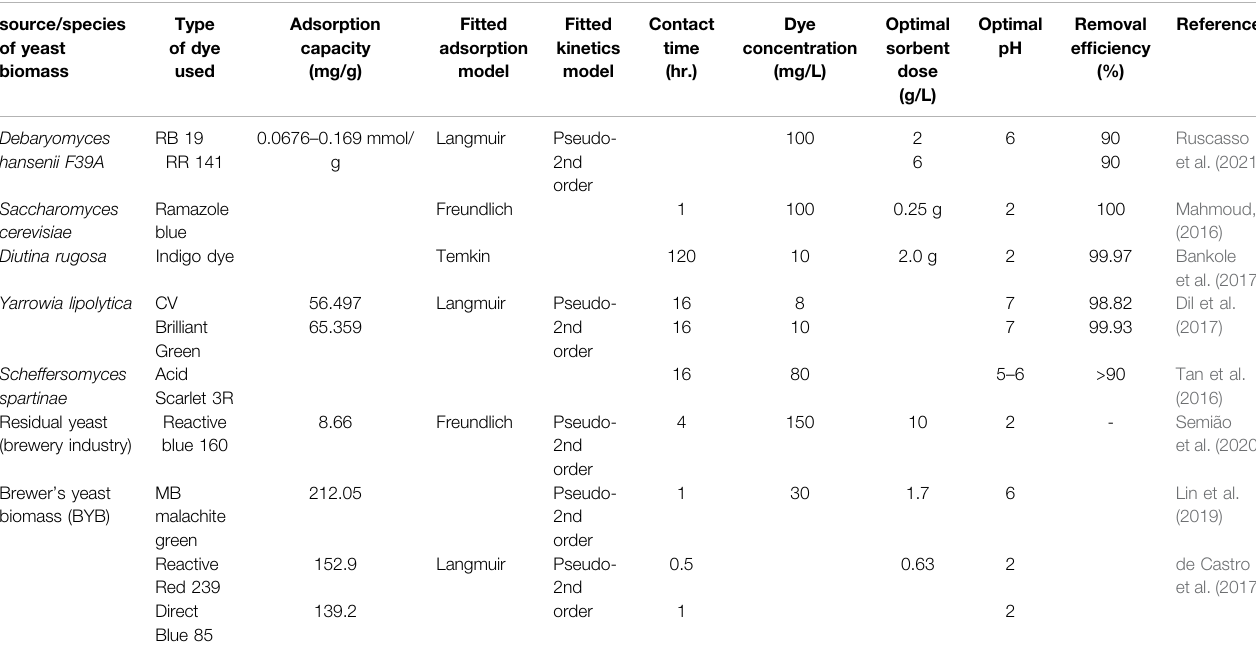
TABLE 6 | Some of the studied yeast species used for dye removal. source/species of